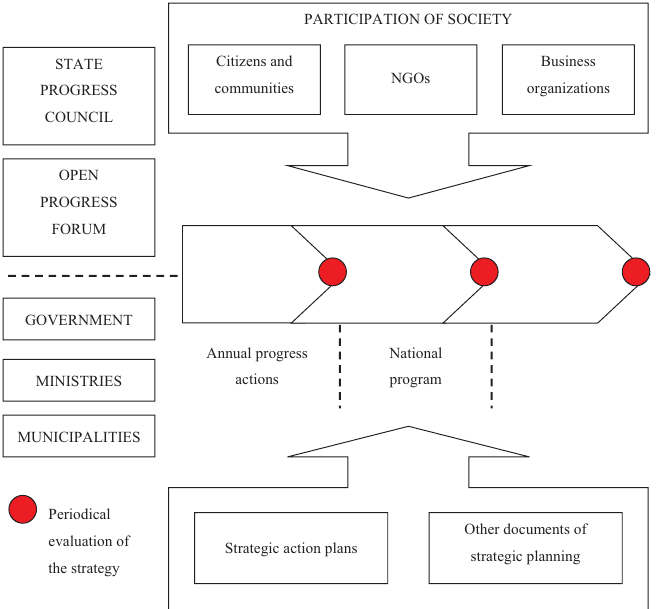
Figure 6. The empirical model of implementation of creative society policy (through the Lithuania’s Progress Strategy Lithuania 2030 (source: created by author, according to Lithuania’s Progress Strat- egy Lithuania 2030 (State Progress Council,